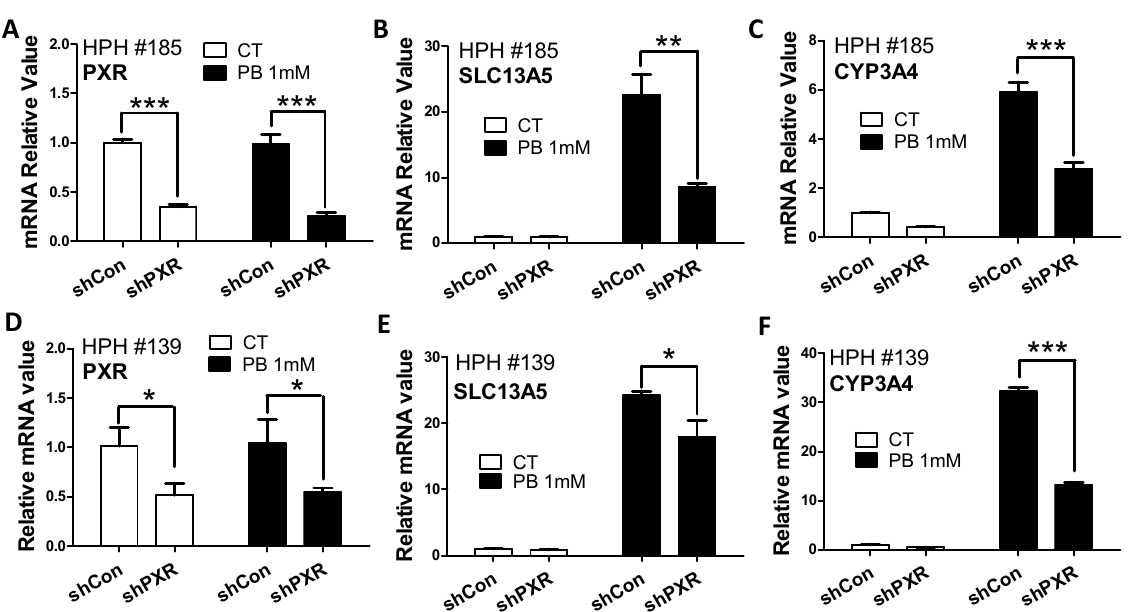
Figure 3. Knockdown of PXR affects PB-induced SLC13A5 expression in HPH. Human hepatocytes from liver donors (HPH#139, #185) were infected with lentiviral/PXR/small hairpin RNA (shPXR) or lentiviral-negative control (shCon) followed by treatment with vehicle control (CT) or 1 mM PB as detailed in Materials and Methods. Expressions of PXR ( A and D ), SLC13A5 ( B and E ), and CYP3A4 ( C and F ) were analyzed by RT-PCR. Data are expressed as mean ± S.D. ( n = 3), (* p < 0.05; ** p < 0.01; *** p < 0.001).